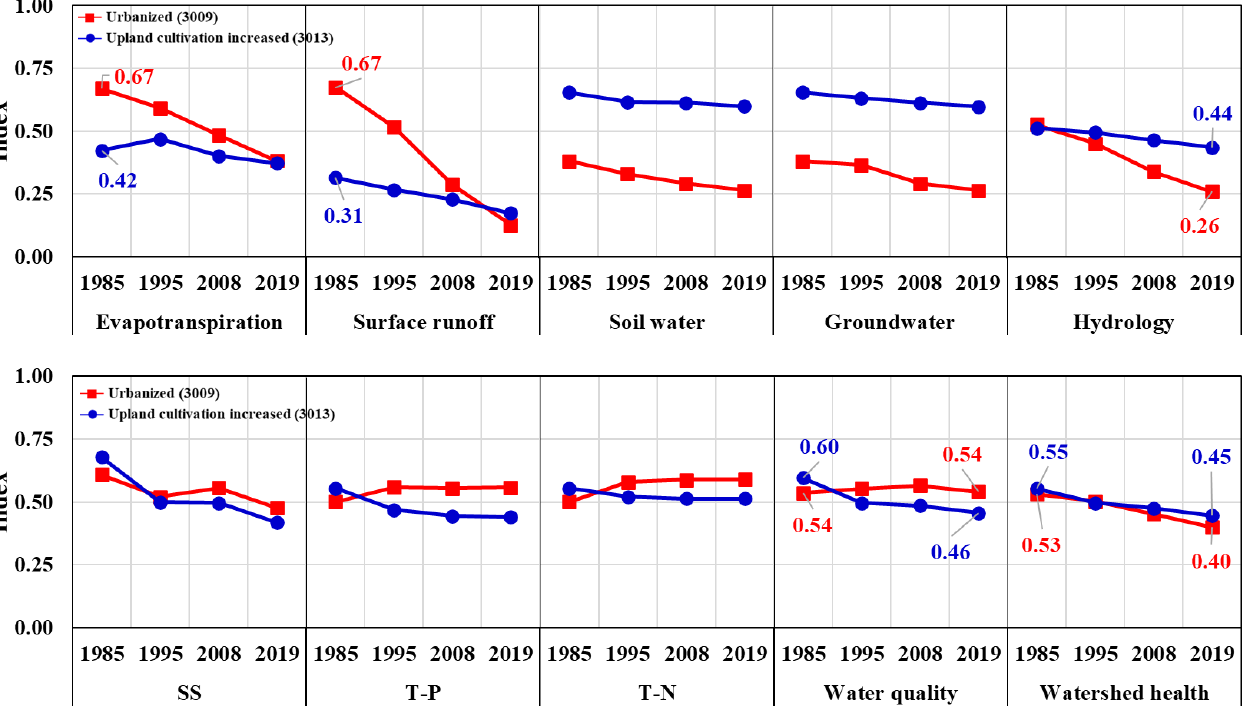
Figure 7. Results of WH changes in urbanized (3009) and upland-cultivation-increased watershed (3013).